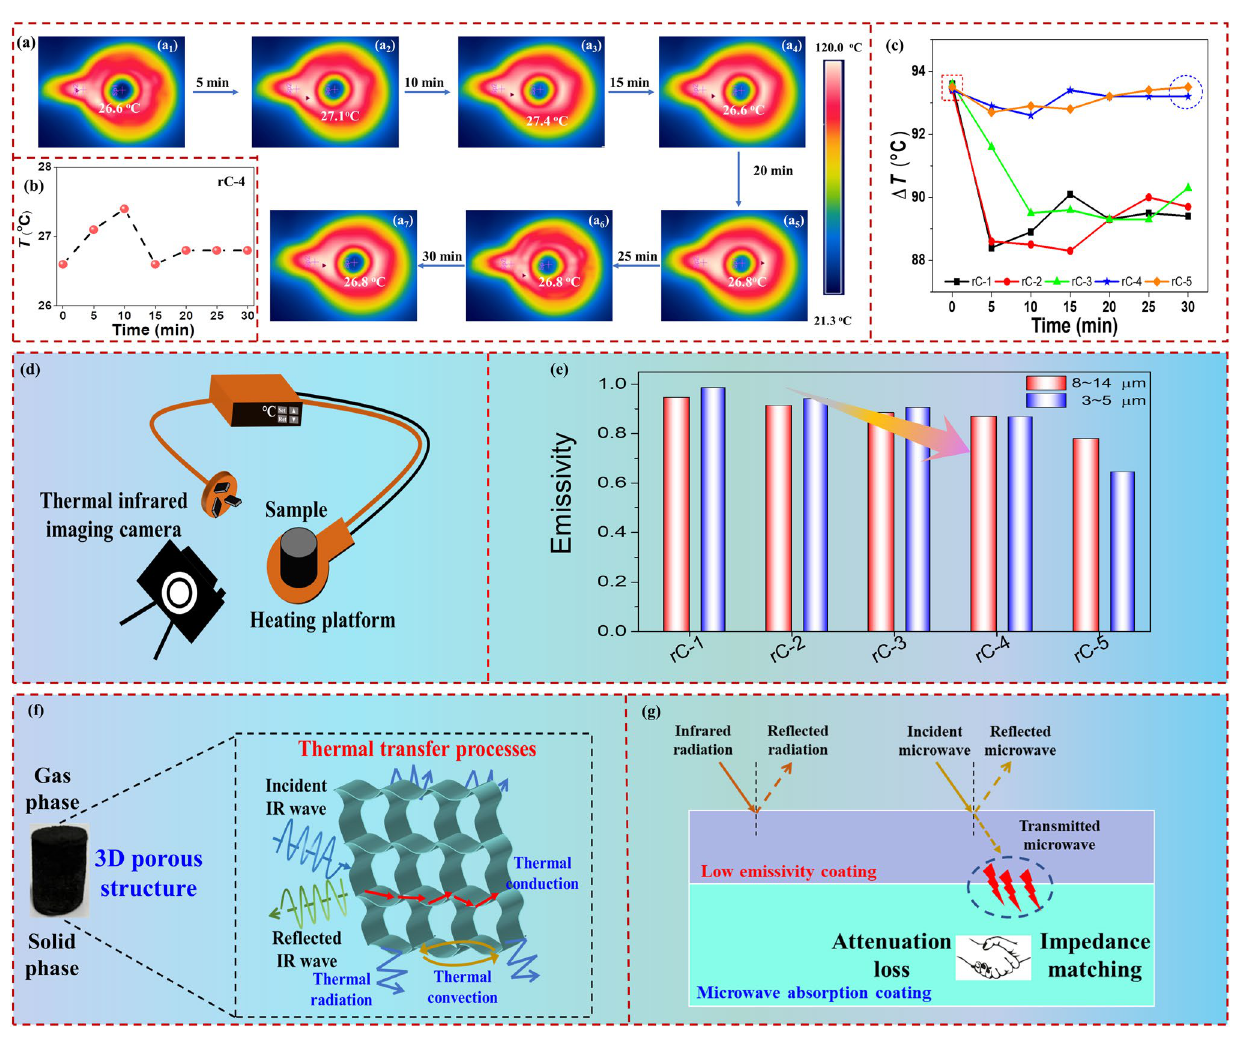
Fig. 7 a Thermal IR images of rC-4 at different heating times. b Surface temperature curve of rC-4. c Difference between heating temperature and surface temperature of rC aerogels. d Schematic diagram of IR thermal imaging test. e IR emissivity of rC composite aerogels at 3 ~ 5 and 8 ~ 14 m. f Thermal transfer processes of porous CuS@rGO composite aerogels. g Schematic diagram of radar-IR compatible